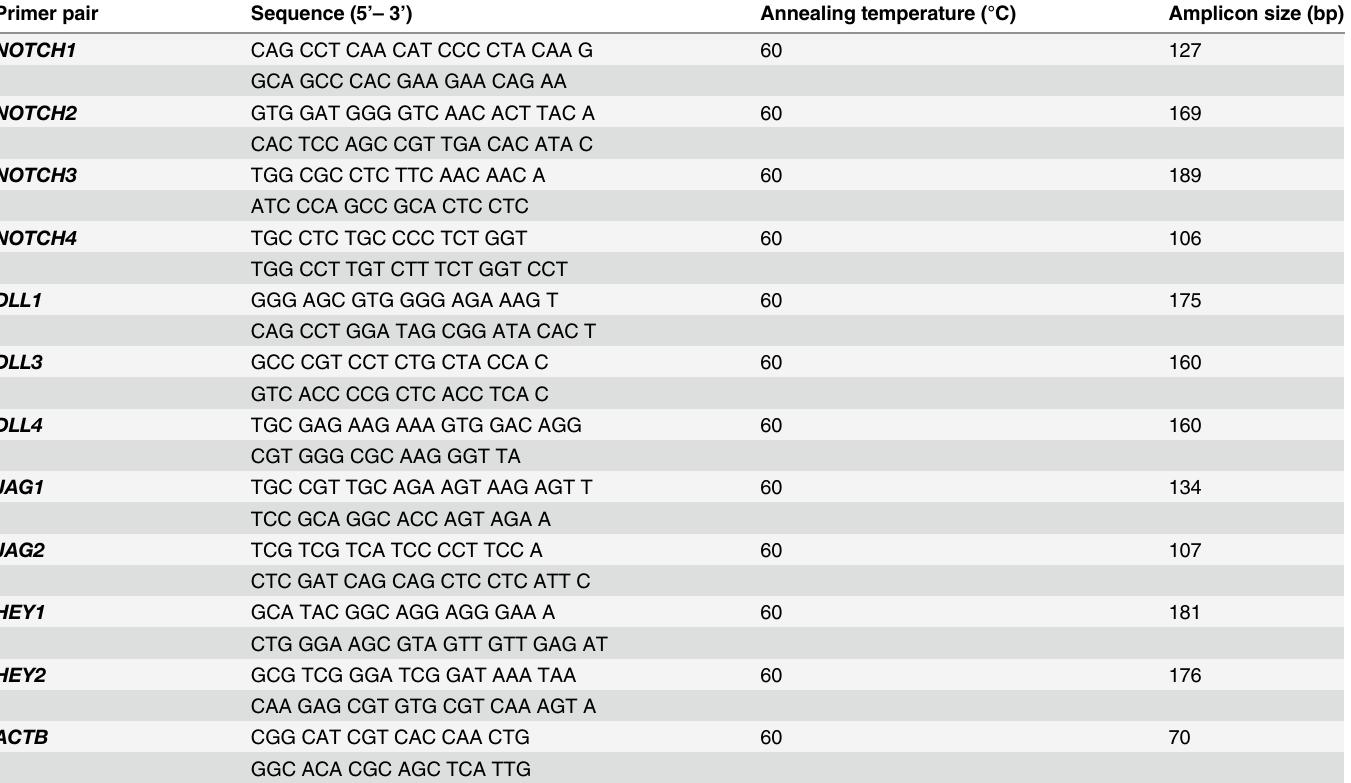
Table 1. Primer sequences, annealing temperatures and amplicon sizes for the qRT-PCR analysis of the studied genes. Primer